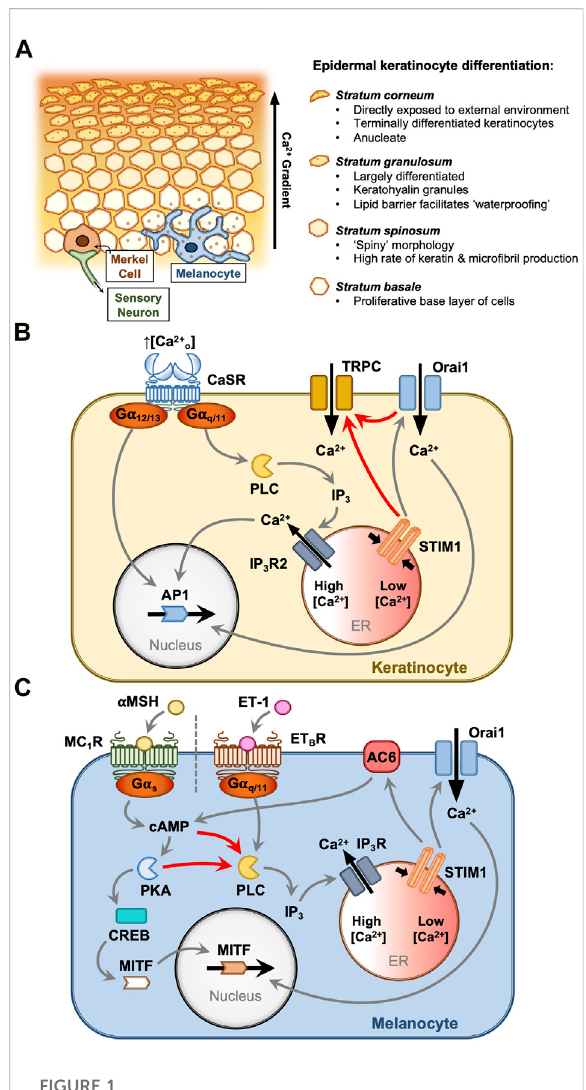
FIGURE 1 STIM1 and Orai1 drive keratinocyte and melanocyte functions in the epidermis. Keratinocytes and melanocytes are critical protective cells in the epidermal layer (A) . Keratinocytes proliferate in the basal layeranddifferentiateinresponsetoelevatedextracellular[Ca 2+ ]. This is drivenbythe Ca 2+ -sensing receptor (CaSR) (B) , whichactivates G α 12/13 and G α q/11 proteins. ER Ca 2+ mobilisation triggers SOCE, and the resultant cytosolic Ca 2+ signals contribute to AP1 activation